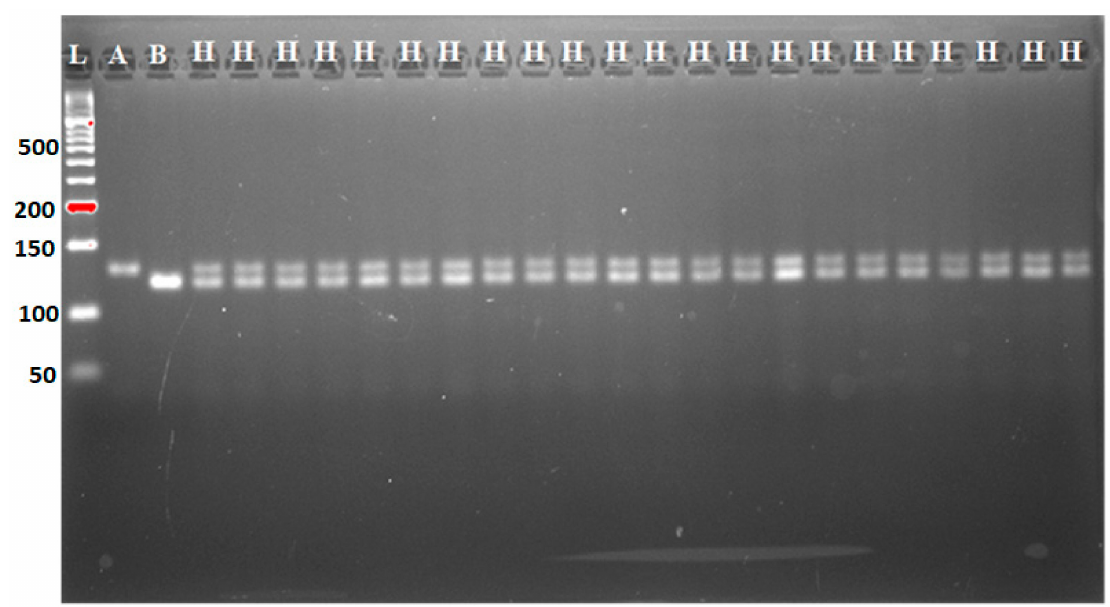
Figure 5. Genotyping and foreground marker-assisted selection of BC 2 F 1 progenies using MP tightly linked marker for ( Xa4 ) Xoo resistance gene. A: MR297; B: IRBB60. H represents heterozygotes; L: 50 bp DNA ladder.